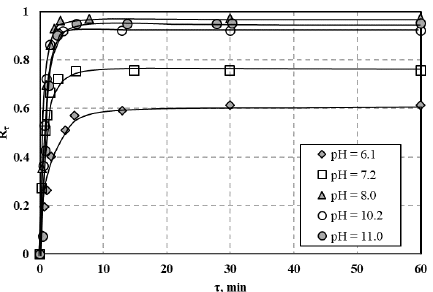
Figure A9. Changes in Zn(II) temporary removal ratio during ion and precipitate flotation from solution containing Al(III), Cu(II), and Zn(II) mixture—effect of pH (c 0 = 0.15 mmol dm − 3 , c SDS = 0.125, u G = 1.51 mm s − 1 ).